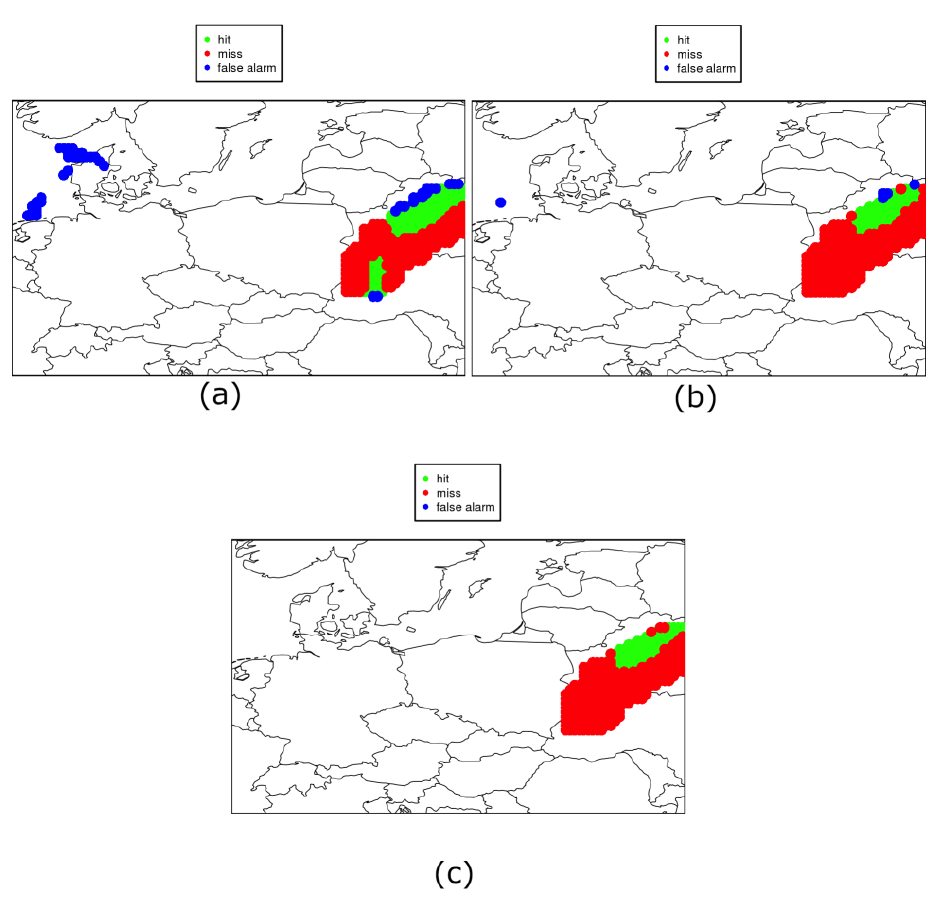
Figure 9. Results of the trained system with respect to the length of the training period. One month of training ( a ); three months of training ( b ); and 6 months of training ( c ).